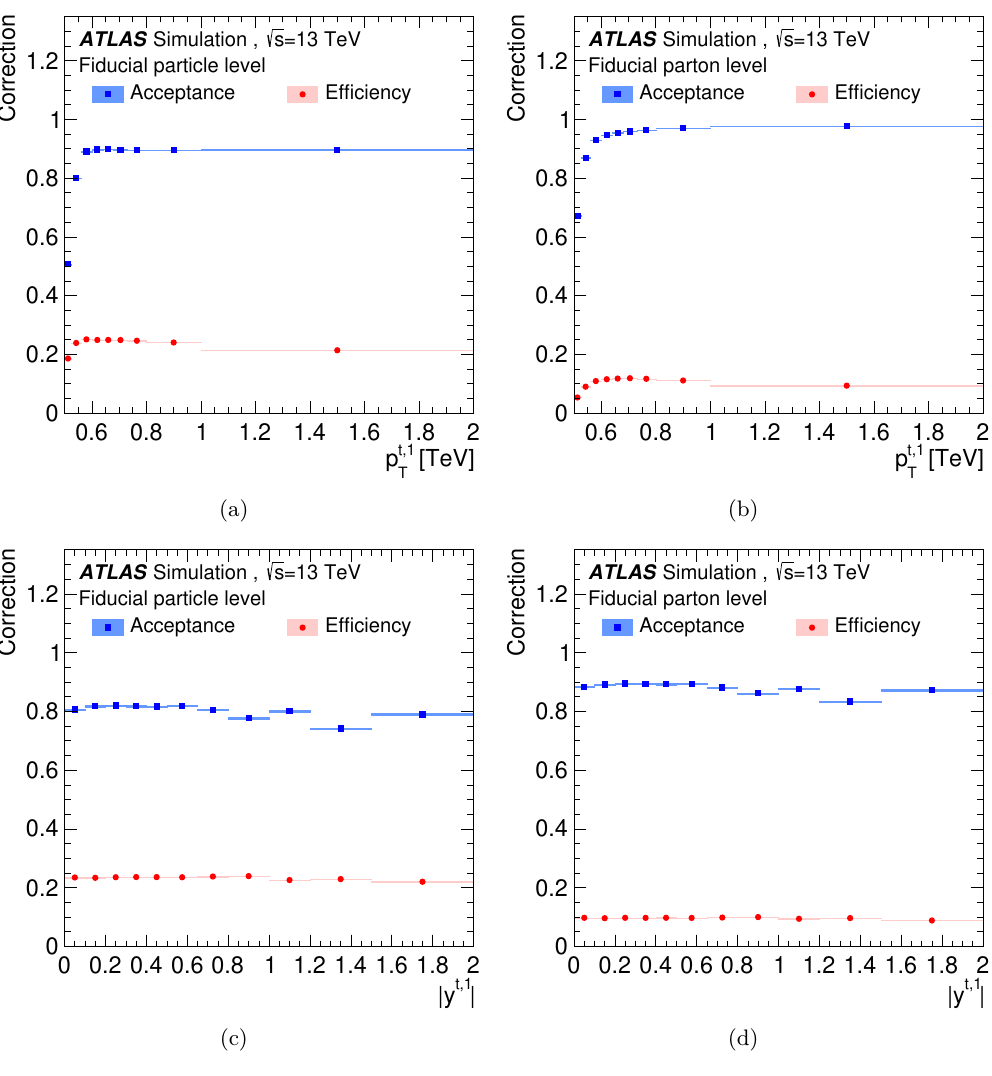
Figure 7 . Acceptance and efficiency corrections as a function of the leading top-quark-jet p T and | y | for the particle-level phase space are shown in (a) and (c), respectively, and for the parton- level fiducial phase space in (b) and (d), respectively. The observables on x -axes are at the truth level when used for the efficiency correction while they are at the detector level when used for the acceptance correction. The Powheg + Pythia 8 generator together with the Geant4 detector simulation framework is used to correct for detector effects. The blue and red bars represent statistical